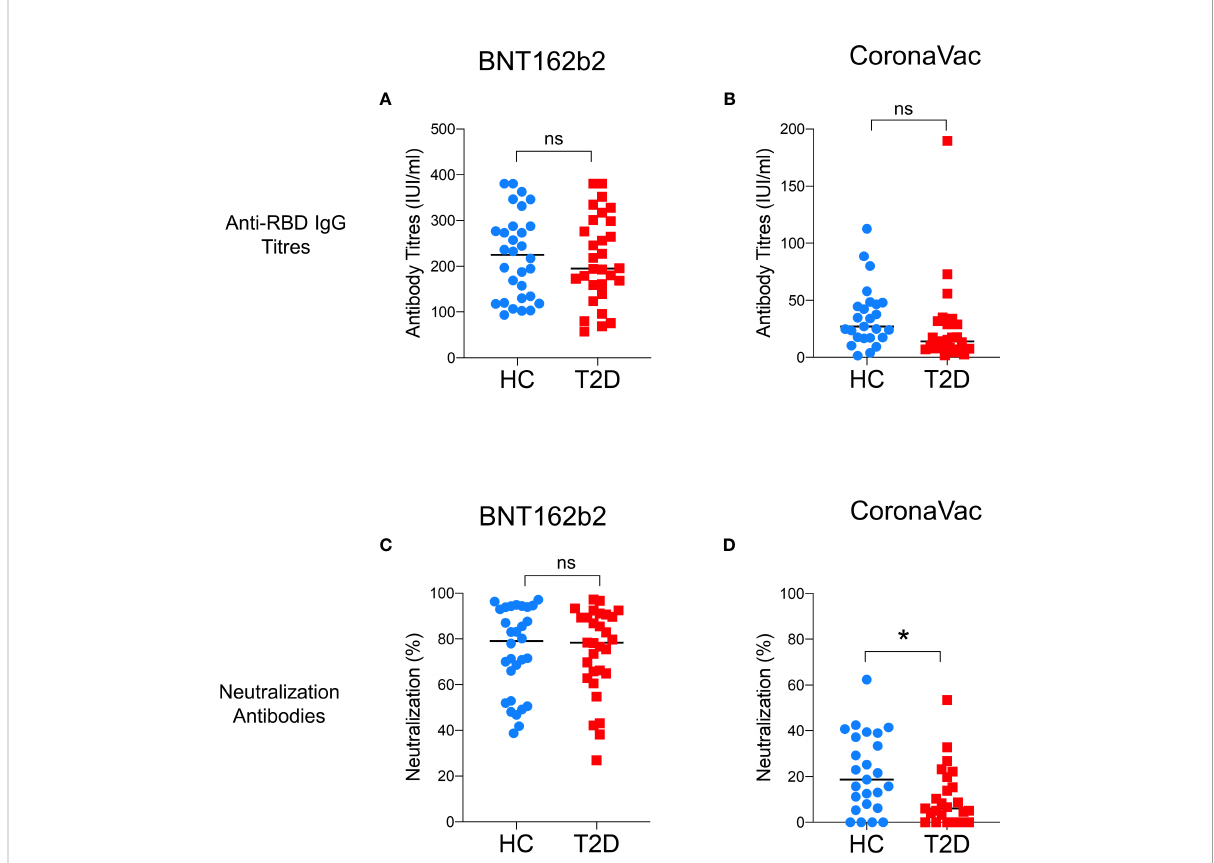
FIGURE 1 Levels of anti-RBD IgG and neutralizing antibodies 3-6 months following BNT162b2 and CoronaVac vaccination. Serum titres of anti-RBD IgG and neutralizing antibodies measured at 3-6 months following the second dose of BNT162b2 (n=30/group) (A, C) and CoronaVac (n=25/group) (B, D) vaccinations. Data shown are median and each symbol represents an individual. ns: not signi fi cant;